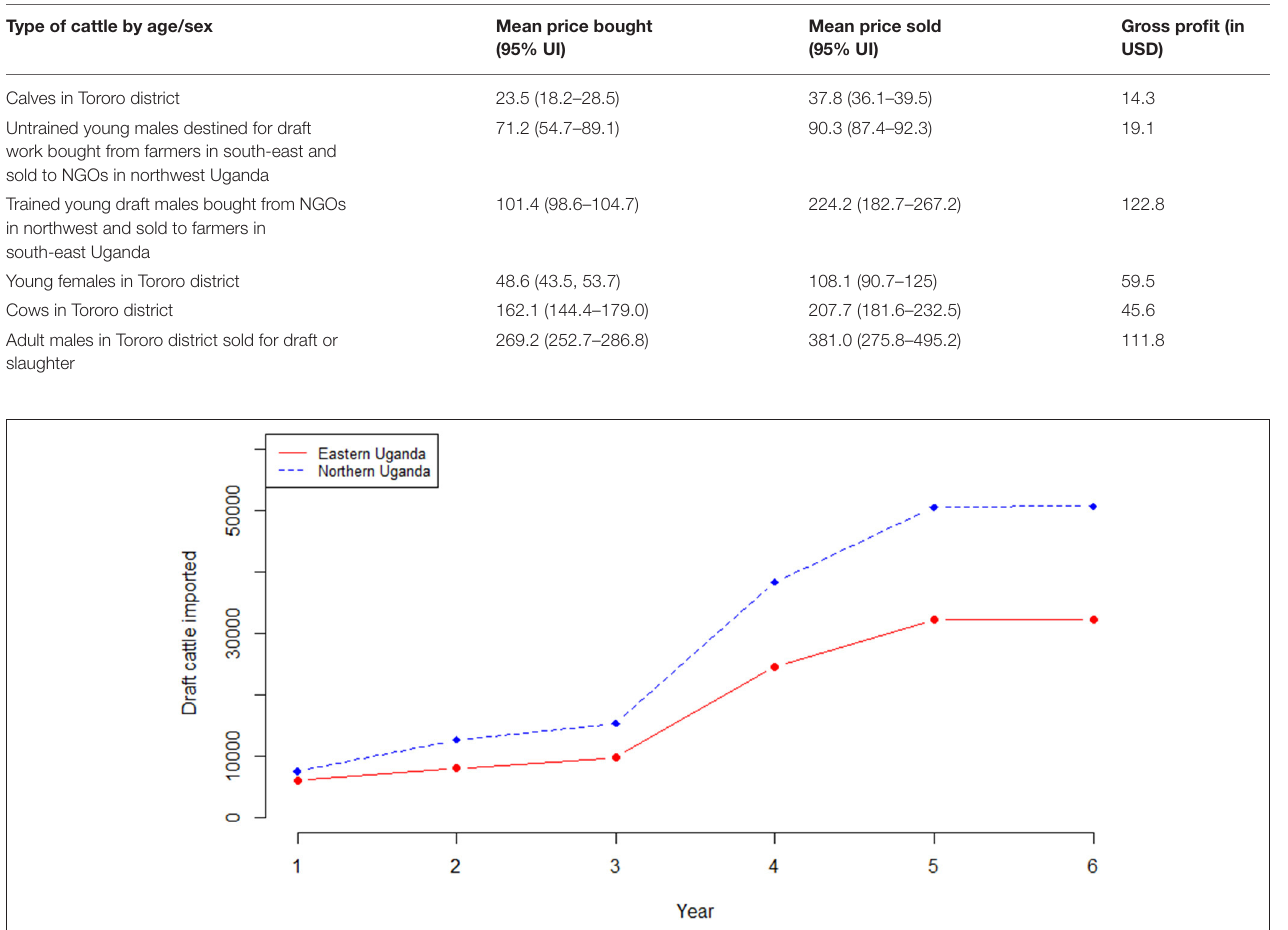
FIGURE 5 | Simulated number of draft cattle imported over a 6-year period.